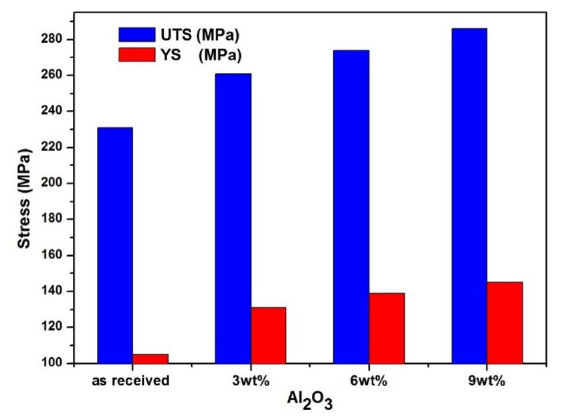
Figure 5: The variation of UTS and YS with Al 2 O 3 wt% in comparison with the experimental